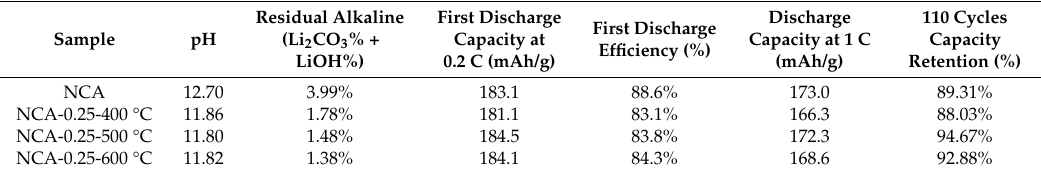
Table 2. Physical and chemical properties of the pristine NCA sample and NCA-0.25 samples at different calcination temperatures from 400 °C to 600 °C.